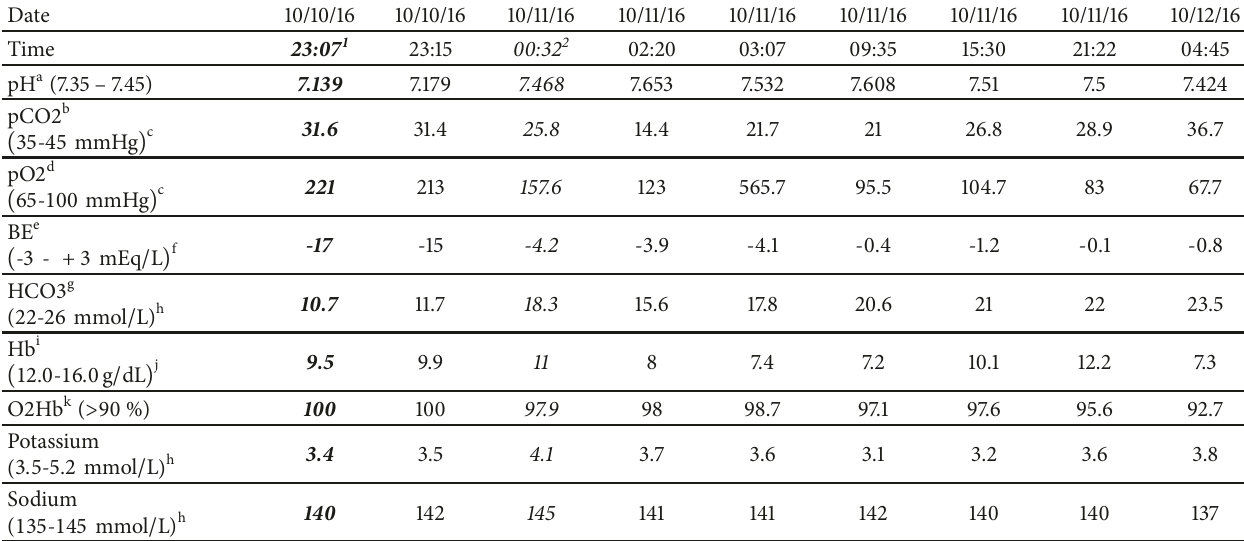
Table 2: Arterial-blood gases during postoperative